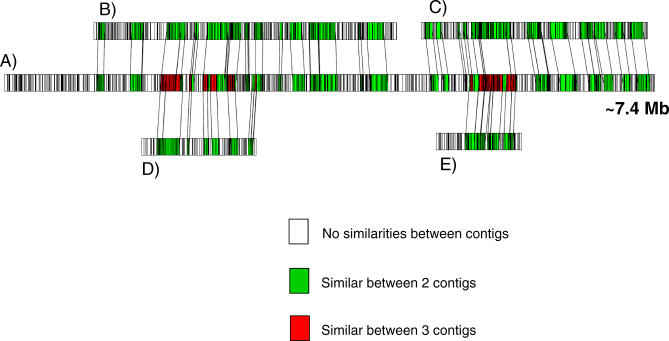
Optical Mapping of the Genomes of Five Pooled Beggiatoa Filaments (35 μm in Diameter)Contigs after assembly of restriction patterns using the enzyme AflII. (A) shows the circular chromosome of 7.4 Mb; (B–D) display linear contigs. The lines connect regions of significantly similar restriction patterns. Green indicates regions displaying similarity between two contigs; red indicates regions displaying similarity between three contigs; white indicates no similarities between contigs.